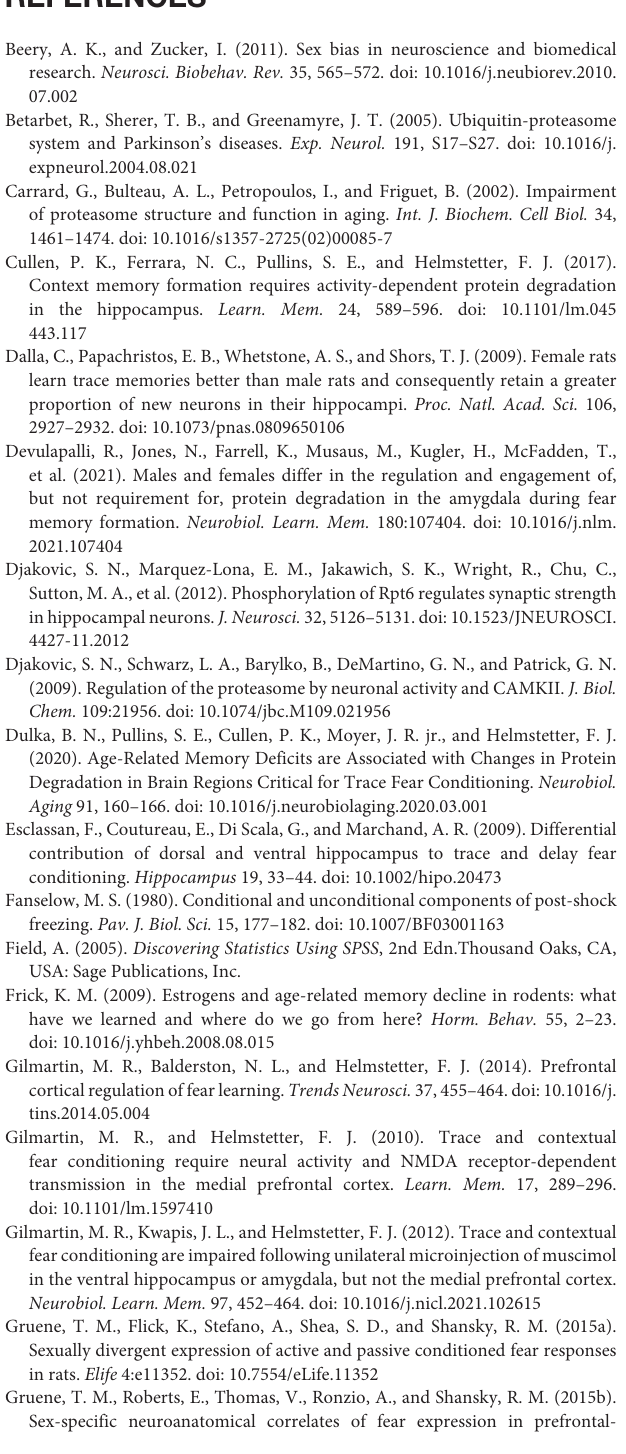
SUPPLEMENTARY FIGURE 1 | Control proteins were analyzed using western blots. In the BLA, total Rpt6 (tRpt6) did not differ in males (A) or in females (B) . β -actin levels also did not differ in males (C) or females (D) . In the DH, tRpt6 did not differ in males (E) or in females (F) . Again, β -actin levels also did not differ in males (G) or females (H) . Results are presented as mean ± SEM.